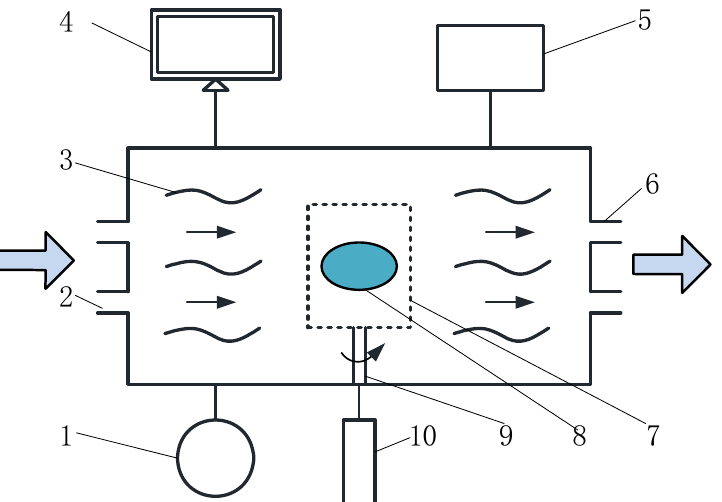
Figure 2. Working principle diagram of the new impregnation freezing equipment. 1—refrigeration equipment; 2—liquid circulation pipe inlet; 3—refrigerant carrier; 4—display; 5—circulation pump; 6—